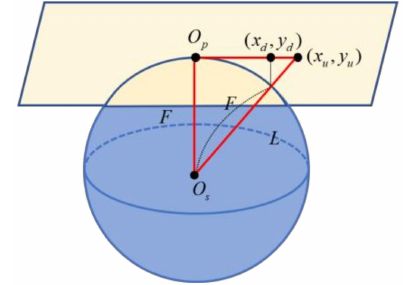
Figure 4. The spherical geometric model.